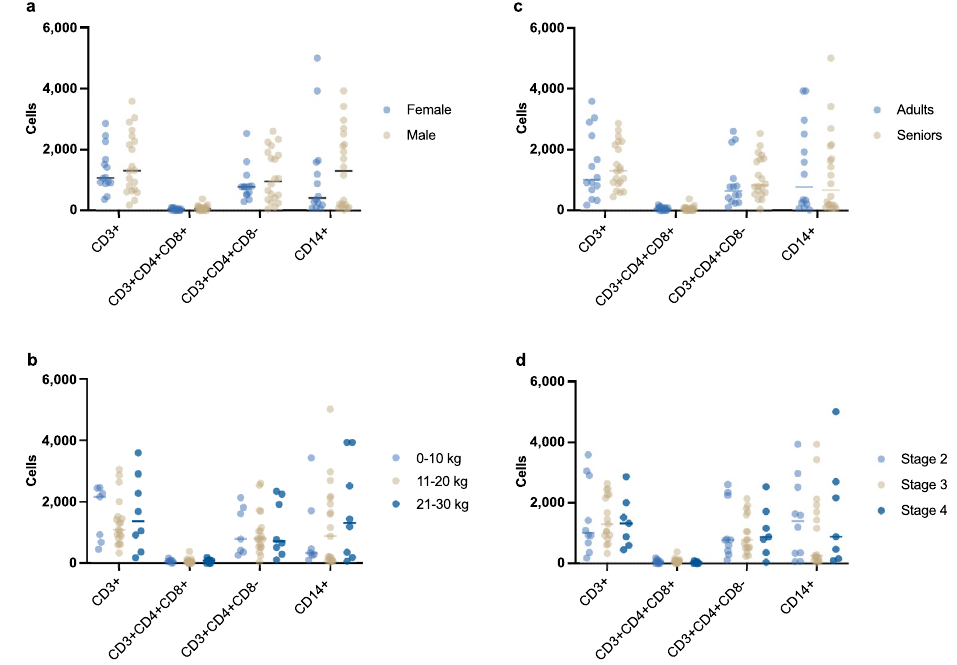
Figure 4. Relation between PMBC subsets and different characteristics of patient groups: ( a ) sex, ( b ) weight, ( c ) age and ( d ) periodontitis stage.